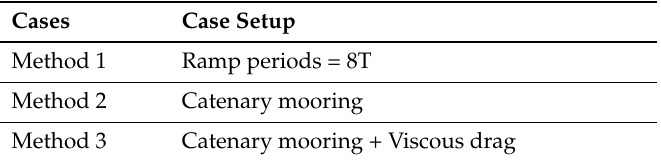
Table 4. Load cases and